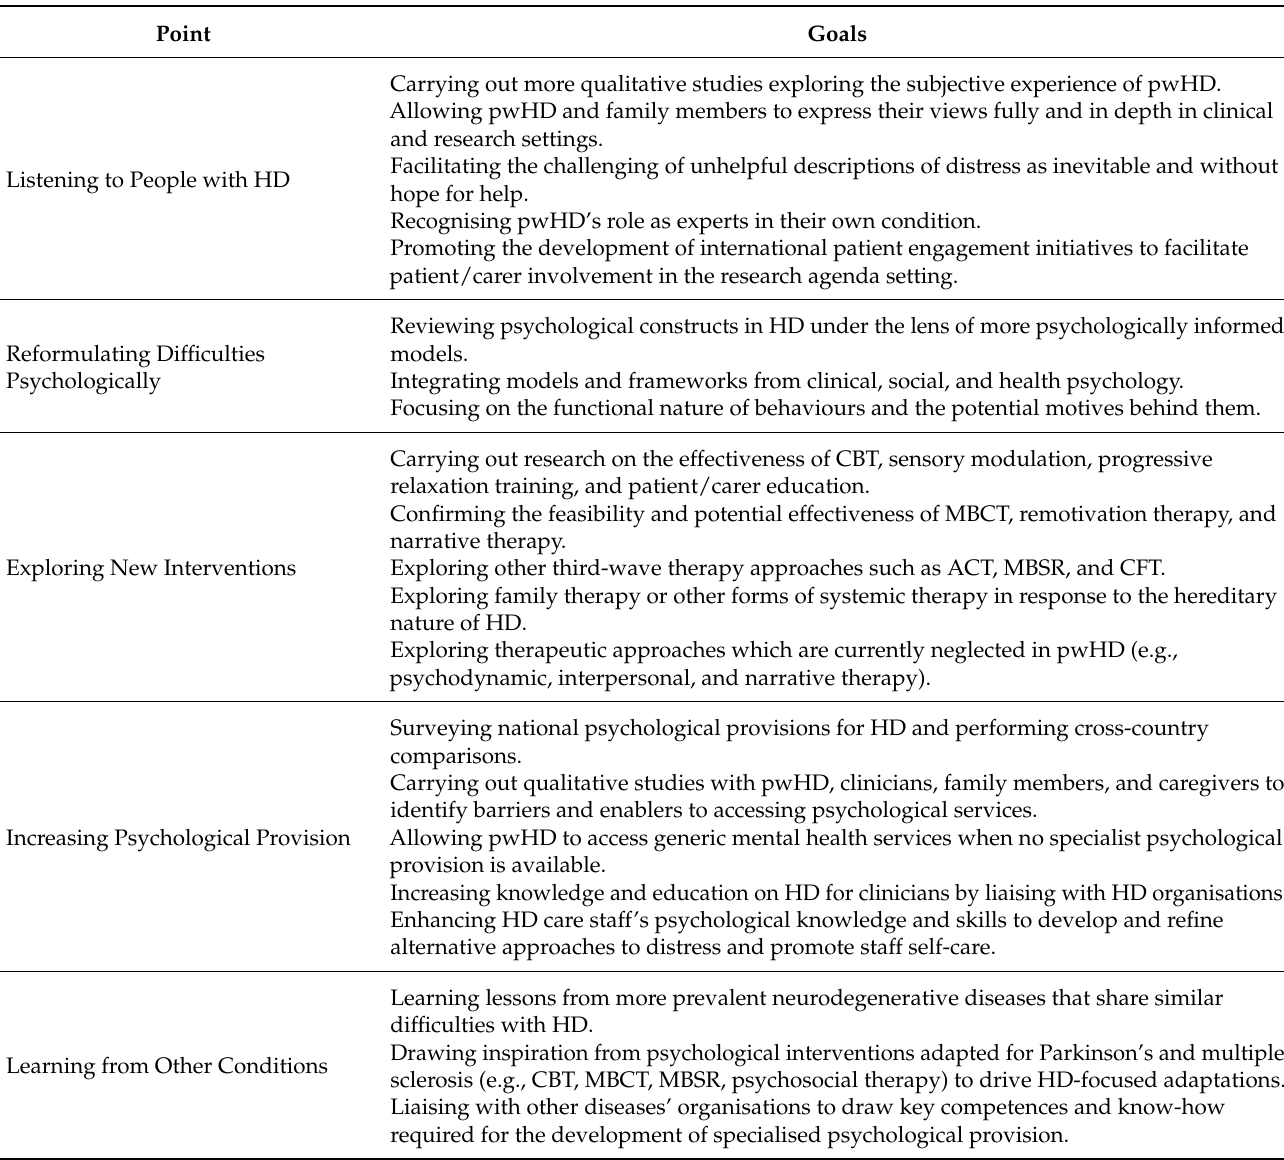
Table 1. Summary of the manifesto’s points and goals. Point Goals